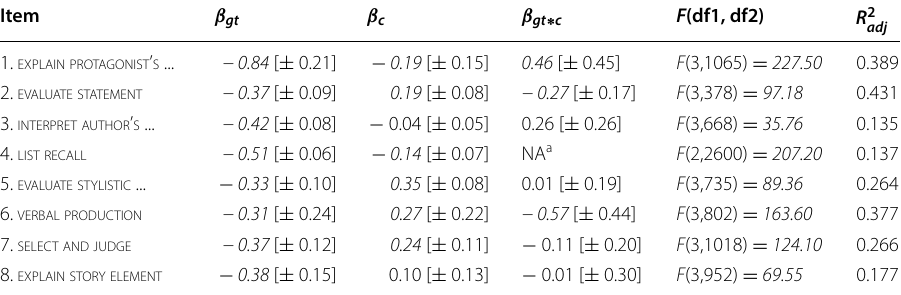
Table 4 Proposition Entity Count (PEC) by gender-specific response types and response